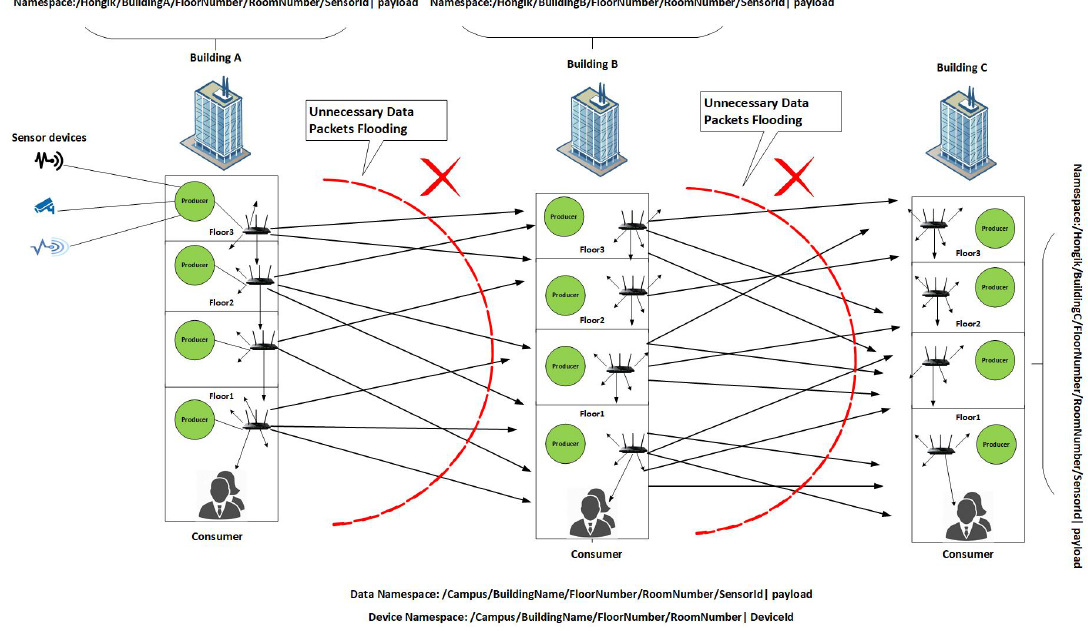
Figure 4. Proposed